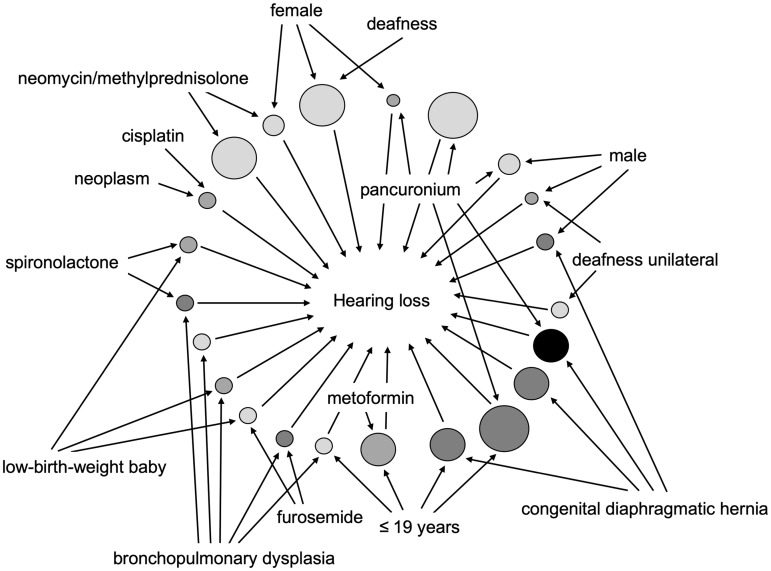
Association rules for drug-induced hearing loss based on the JADER database between April 2004 and June 2018.Support and lift were presented using the R-extension package arulesViz which implements novel visualization techniques to explore association rules. The plot arguments in the arulesViz were set as follows: method = “graph,” measure = “support,” and shading = “lift.” The support measures were visualized by the size of the circle area. The lift measures were presented by the color shade of the circles.